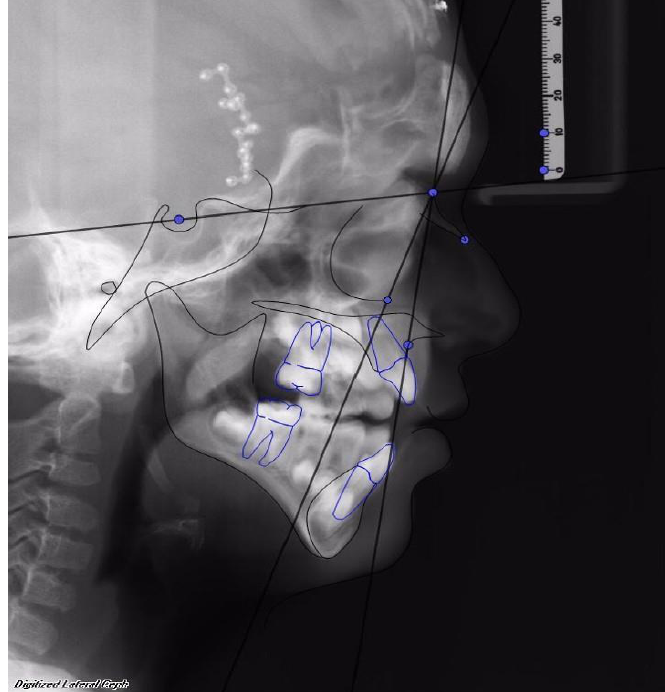
Figure 2. First patient, female, 6 years old, affected by Crouzon’s Syndrome. Osteodistraction (OD) was removed after 40 days before the established time of osteodistraction for fractures of bone support caused by accidental trauma. Osteodistraction was finished with an advancement of 23 mm. The advancement was interrupted before the normalization of the SNA angle to stop bone advancement. After removal of the OD device, the SNA was 75° and the SNOr was 63°.